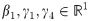
Maximization of correlation with subjective opinion (phase one and phase two).Phase one (left) involved the joint optimization of the following parameters: β, γ of the 1st stage and b, σ, γ, c of the 4th stage. In this case β1,γ1,γ4∈R1 and β4,σ4,c4∈R14 one parameter per orientation (with 4 orientation) and scale (with 4 scales) plus both residuals. Note that even though the relatively small number of parameters, the dimensionality is still huge to allow a brute force approach. Given the computational cost of phase one we used stochastic gradient descent on a extremely small training set. Results shown in the curve correspond to the randomly varying training set. In phase one the correlation for the whole database only arrives up to 0.84 because more iteration would be required. Phase two (right) only involved the optimization of b4. This is fast enough to use deterministic gradient ascent training with half the database. However, note that if no structure is imposed in b4, it has thousands of elements thus brute-force is not possible. In this case, correlation results shown correspond to the whole database (indicating proper generalization). The parameters leading to the maximum correlation in the test set (peak of the red curve) are those used for the scatter plot of Fig 10.